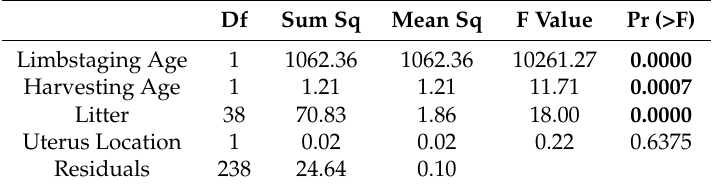
Table 2. ANOVA for Crown-Rump Length. Statistically significant p -values bolded .